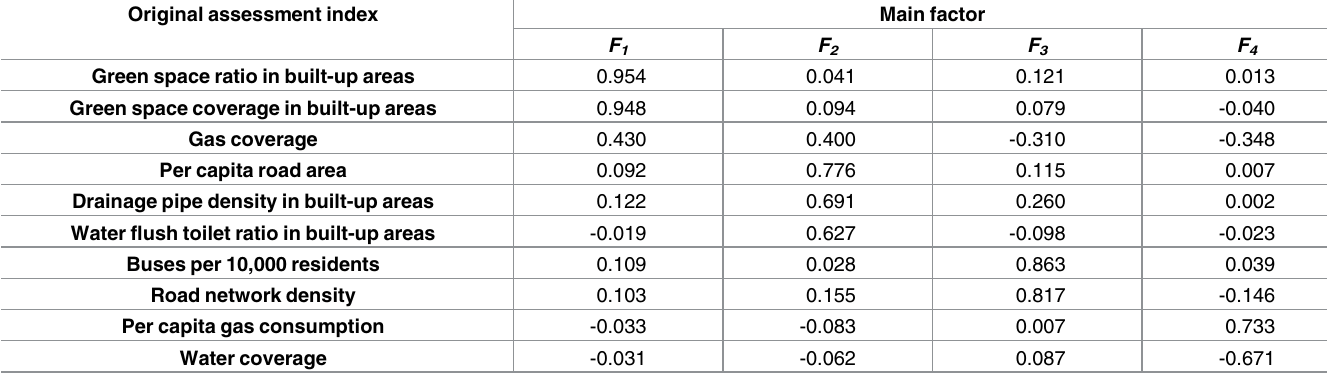
Table 4. Factor loading for comprehensive municipal infrastructure development after